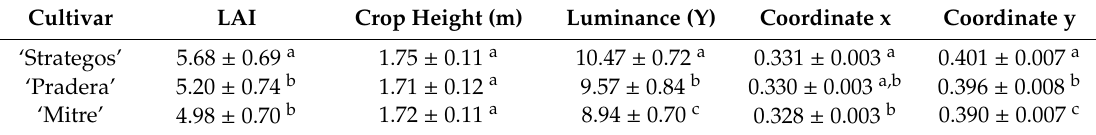
Table 1. Averages of the three N treatments of leaf area index (LAI), crop height, luminance (Y), coordinate x and coordinate y for each cultivar of cucumber ( Cucumis sativus L.) crop grown in 2018. Values are means ± standard error. There were twelve measurements of each parameter for each cultivar, three for each N treatment. Di ff erent lower-case letters (a–c) show significant di ff erences between